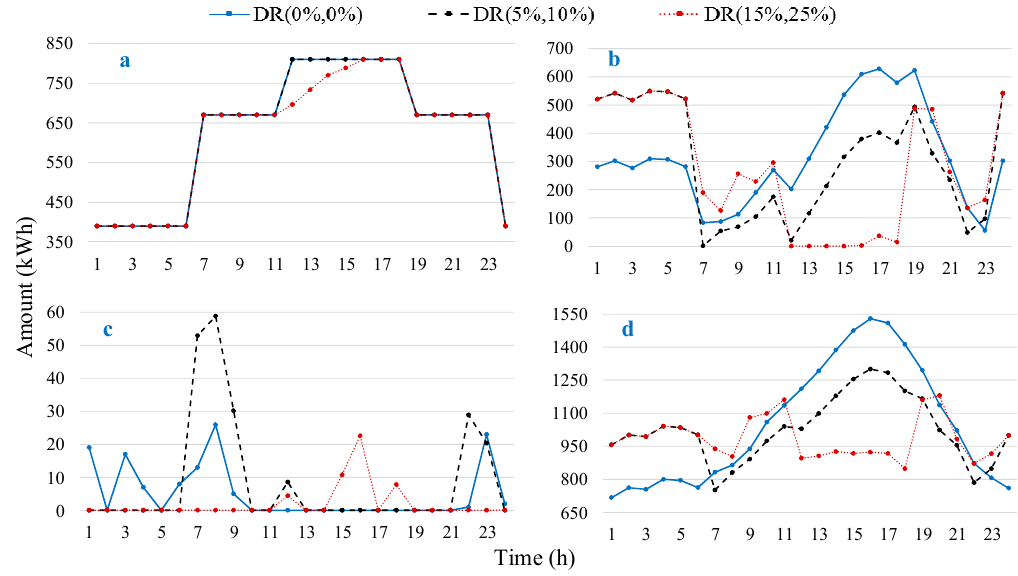
Figure 6. ( a ) Generation of CDGs; ( b ) external power trading; ( c ) internal power transfer; ( d ) load profile.